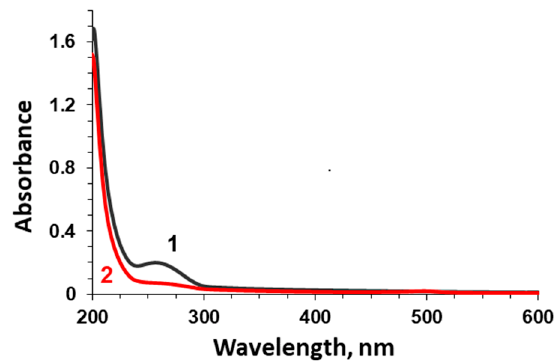
Figure 2. Absorption spectra of commercial (black line 1) and purified (red line 2) 0.1 mg mL − 1 mucin.